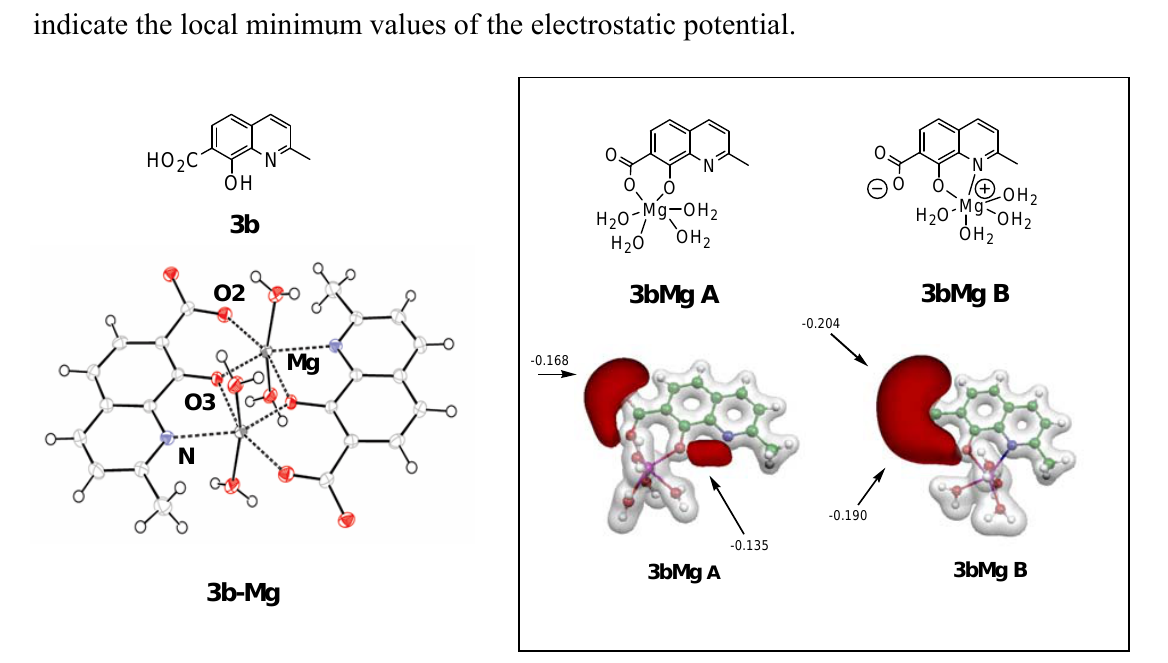
Figure 4. Structures of 3b and X-ray structures of magnesium complex 3b-Mg . DFT electrostatic potential features of putative magnesium complexes 3b-Mg A , 3b-Mg B. Grey and black isosurfaces correspond to + 0.20 and -0.10 a.u., respectively. The arrows indicate the local minimum values of the electrostatic